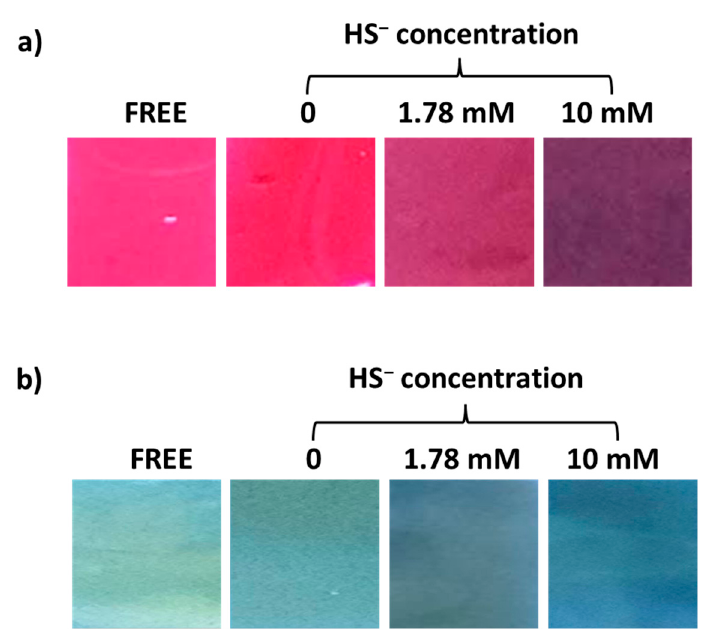
Figure 6. Real color images of a cropped area of the model complex—reported in Figure 5—( a ) and complex 1 ( b ) loaded in sol-gel matrices after adding increasing amounts of HS − dissolved in H 2 O (0, 1.78, and 10 mM). Non-treated matrices are indicated as FREE.